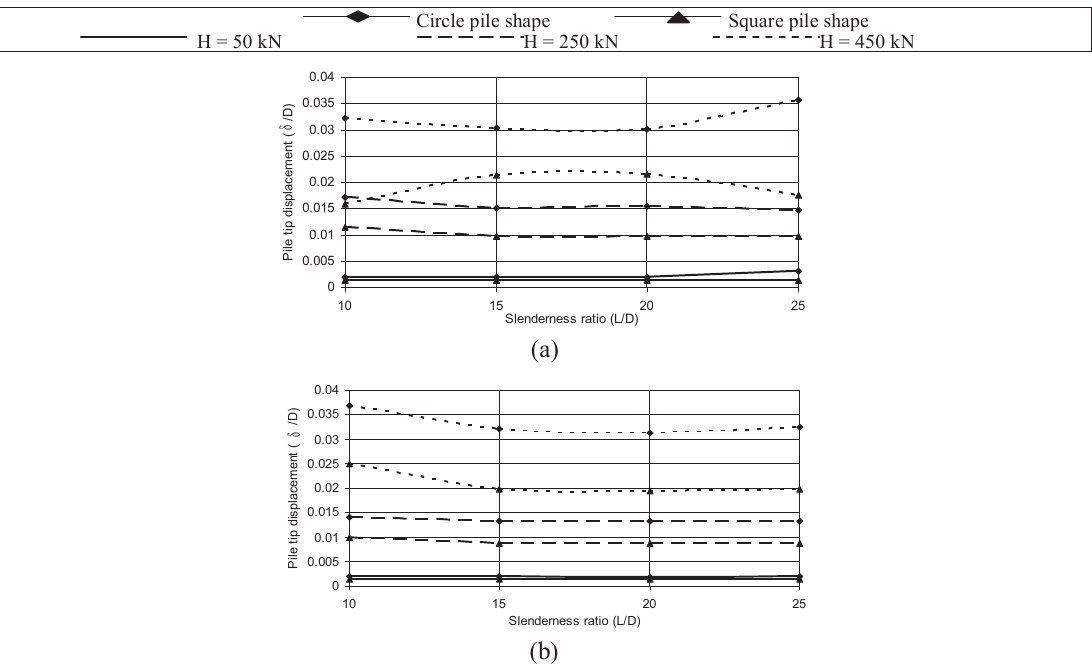
Figure 8: Predicted lateral tip displacement versus pile slenderness ratio under the influence of lateral load intensities and pile shape: (a) cohesionless soil and (b) cohesive soil